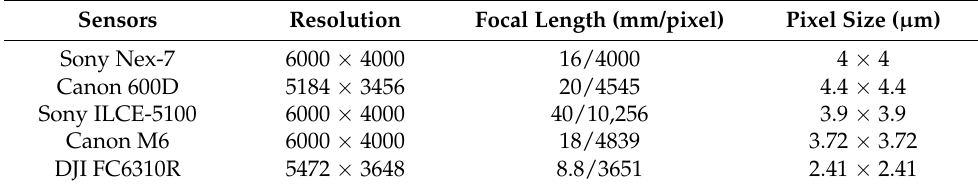
Table 2. Basic information of the cameras used in the